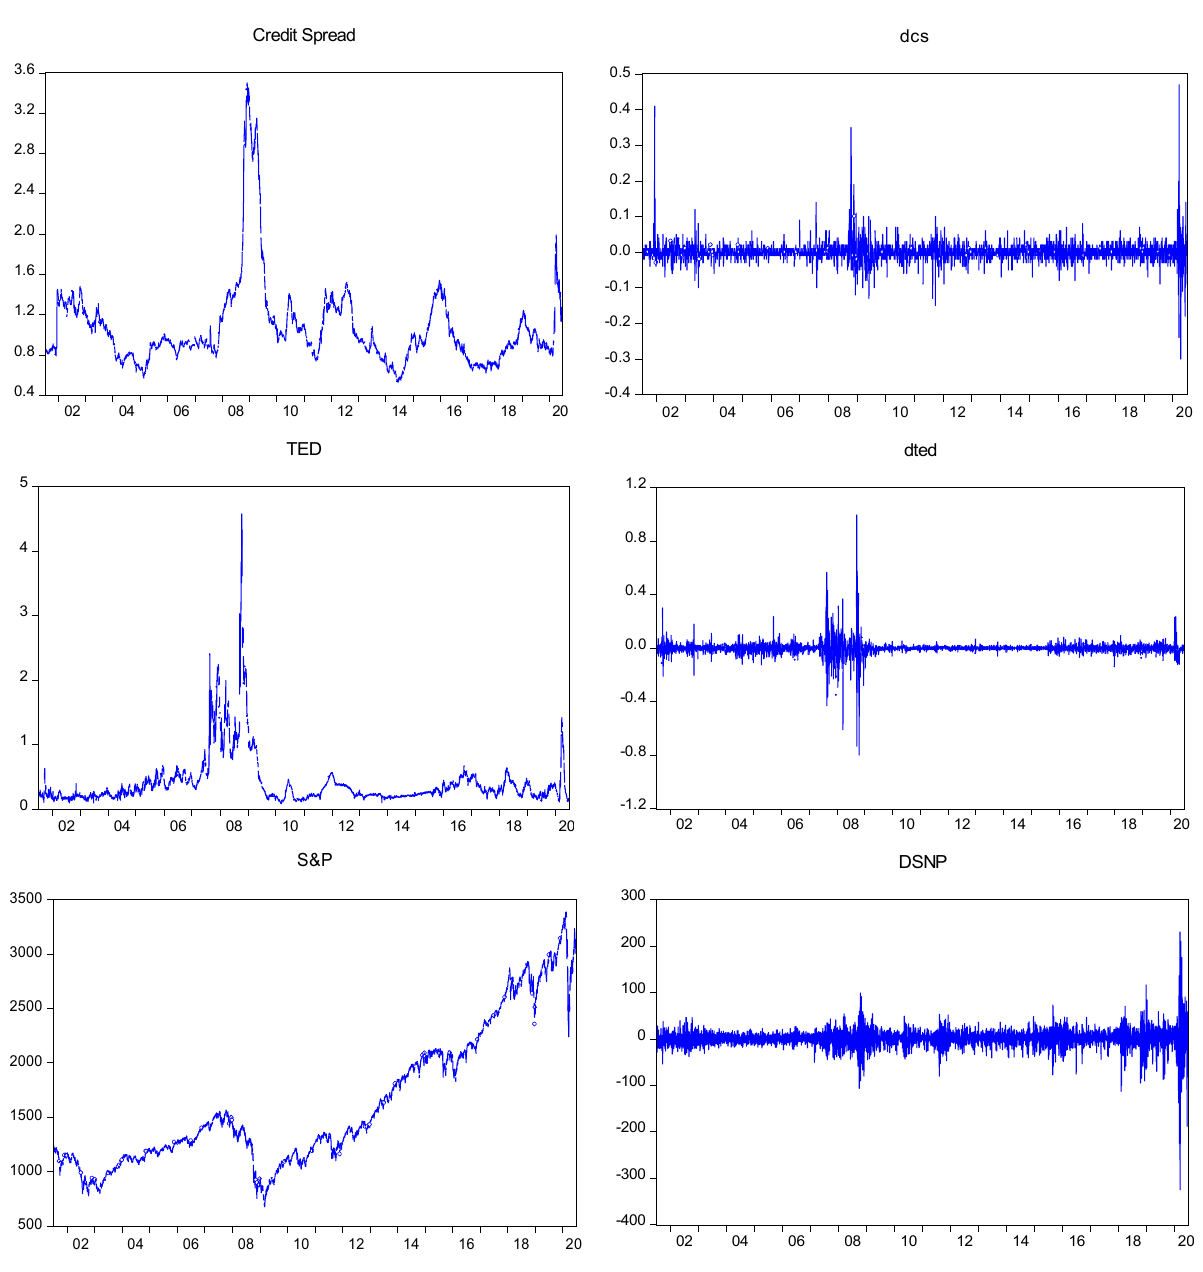
Figure 6. Time series volatility for Credit Spread, TED Spread, S&P 500 index levels ( left ) and returns ( right ) for the full sample between July 2001 to June 2020.